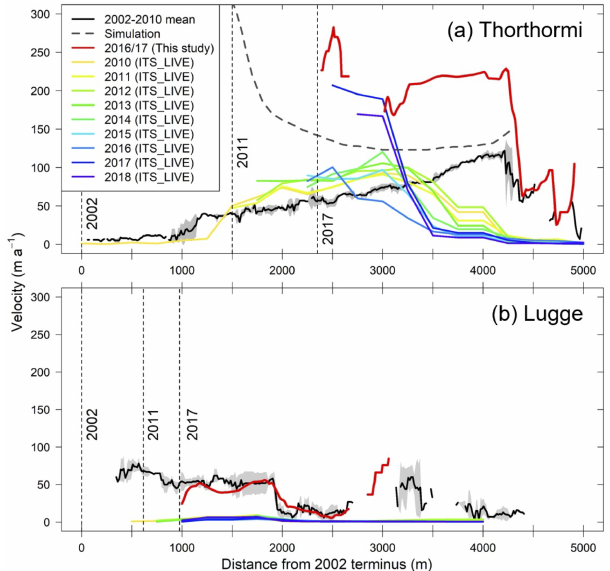
Figure 4. Central flowline velocities of (a) Thorthormi and (b) Lugge glaciers. Dashed vertical lines indicate the glacier ter- minus positions in 2002, 2011, and 2017. The red lines represent the flow velocity that was calculated in this study (2016–2017). In- terannual velocities (2010–2018) are extracted from the ITS_LIVE velocity product. The black lines and grey shaded regions repre- sent the mean and standard deviation of the flow velocities for the 2002–2010 period, respectively (Tsutaki et al., 2019). The thick dashed line in (a) denotes the simulated surface velocities with a lake-terminating assumption (Tsutaki et al.,